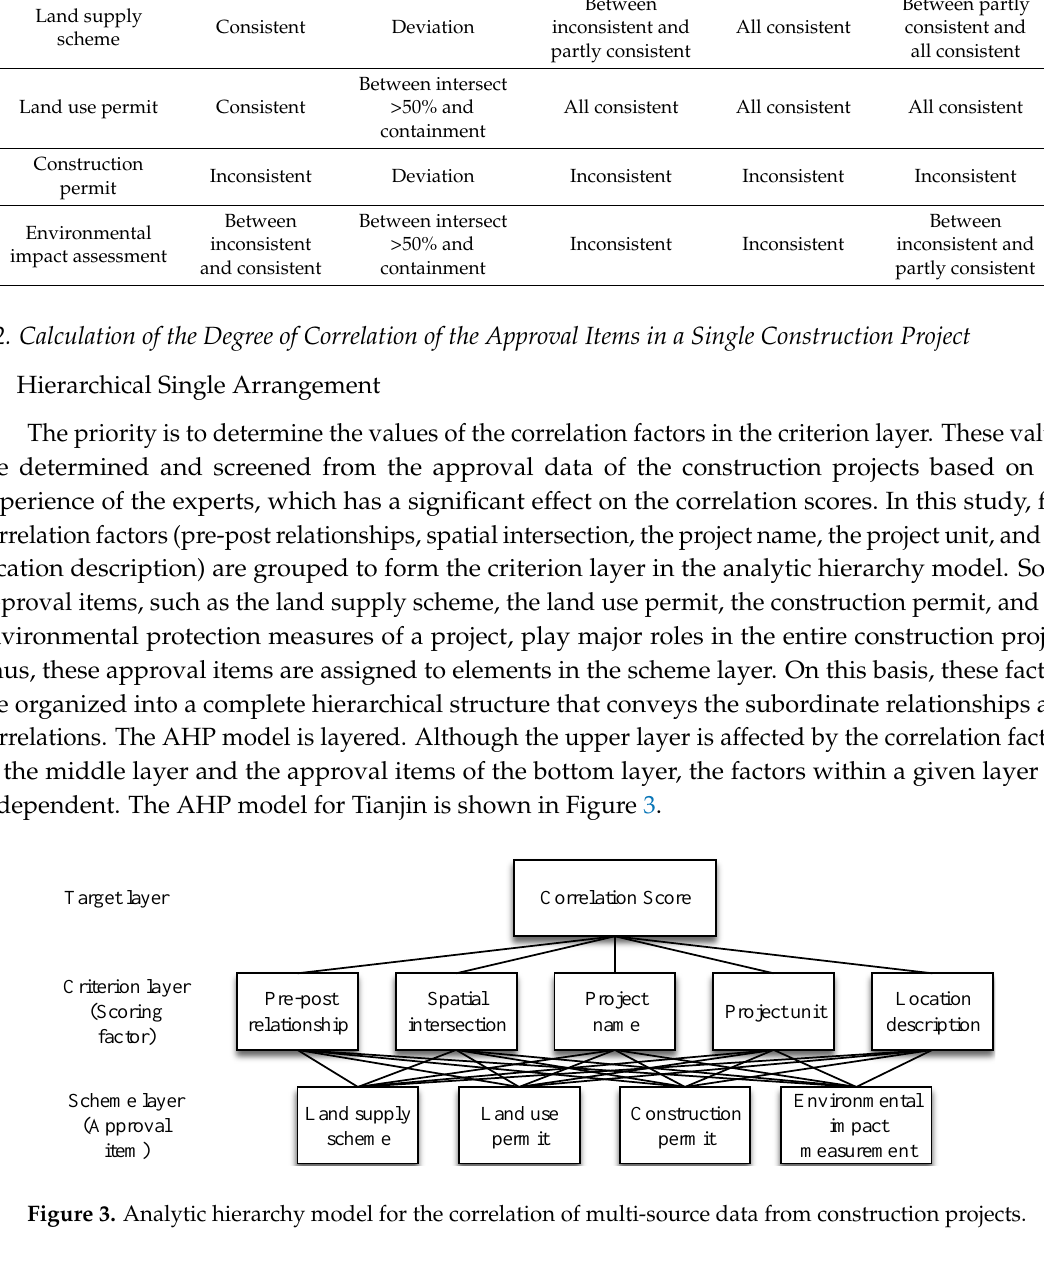
Table 4. Judgment matrix for the scoring factors of the criterion layer.